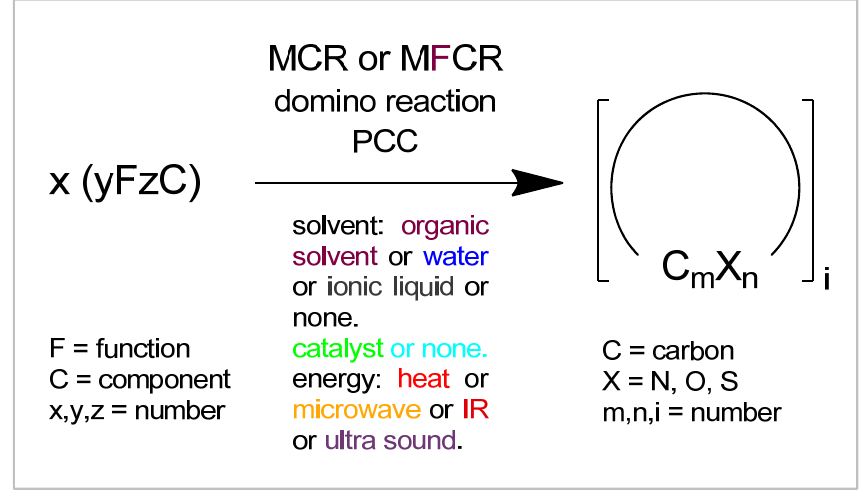
Figure 1. Strategies and tools to design DOS for complex heterocycles by